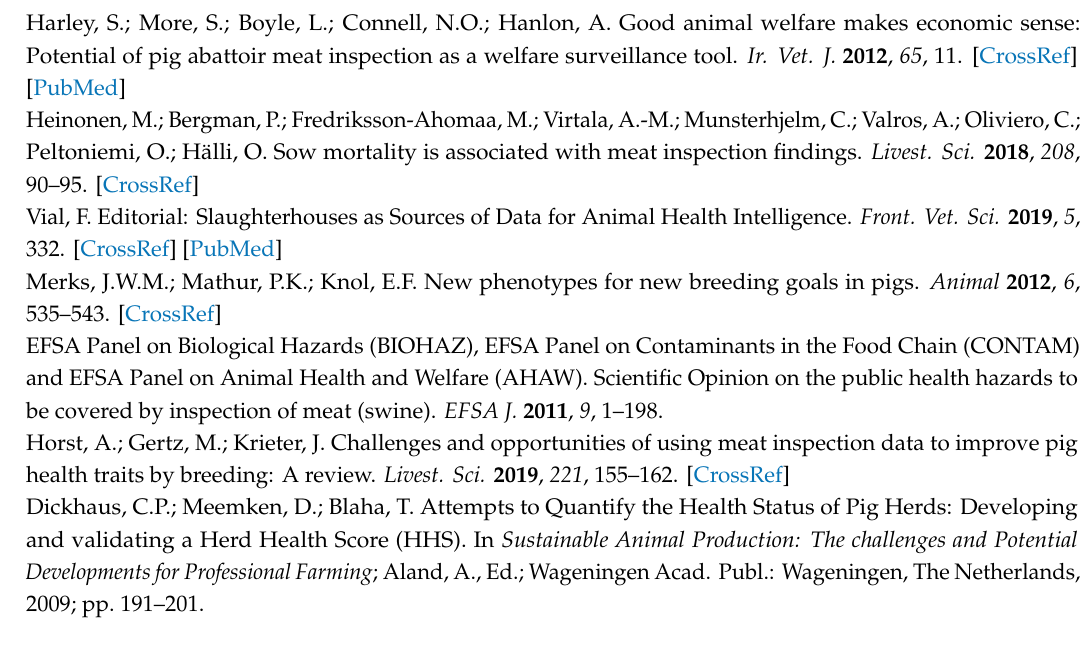
Figure S1: Retransformed random estimates (%) of slaughter day (solid line), nested in abattoir, in the course of half-year periods and the moving average (dashed line) for all abattoirs (A1-A9) and focused organs. Figure S2: Excluding of A6. Deviations in lung prevalence of abattoirs mean compared to the grand mean of the half-year period S1. Dot = abattoir deviation; bracket = 90% confidence interval; dashed line = grand mean. Calculated grand mean (GM) based on the LSM of each abattoir: GM s1 = 9.02%. Figure S3: Excluding of A5. Deviations in lung, pleura, liver and heart prevalence of abattoirs mean compared to the grand mean of the half-year period S3. Dot = abattoir deviation; bracket = 90% confidence interval; dashed line = grand mean. Calculated grand